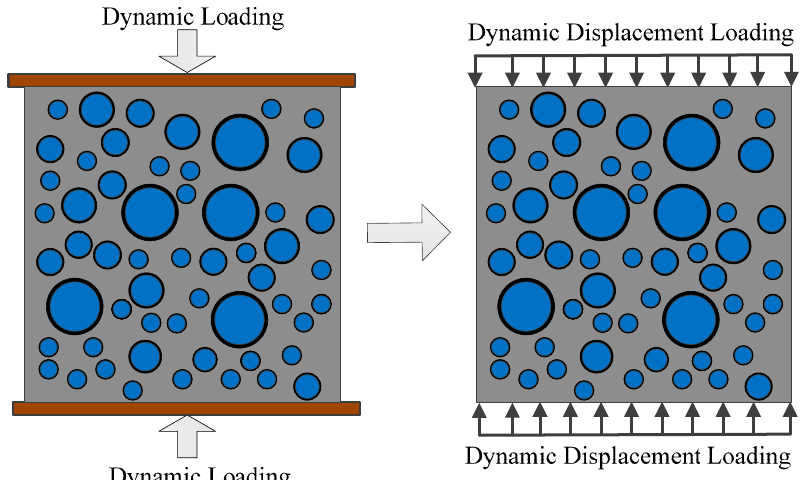
Figure 7. Loading model of compression test.